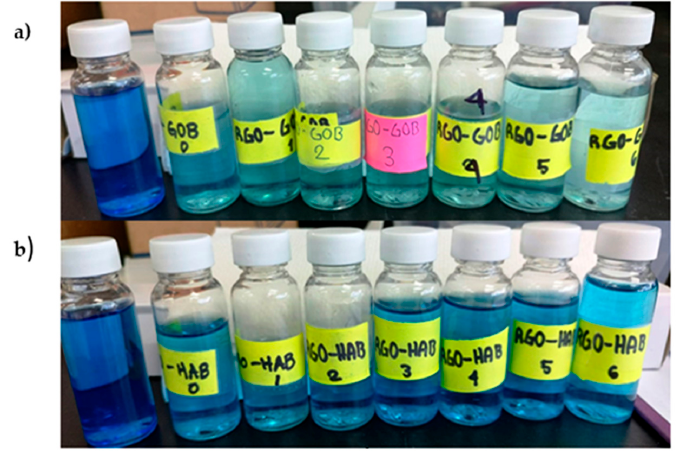
Figure 12. Degradation of dye ( a ) RGO with gobernadora extract and ( b ) RGO with habanero extract.